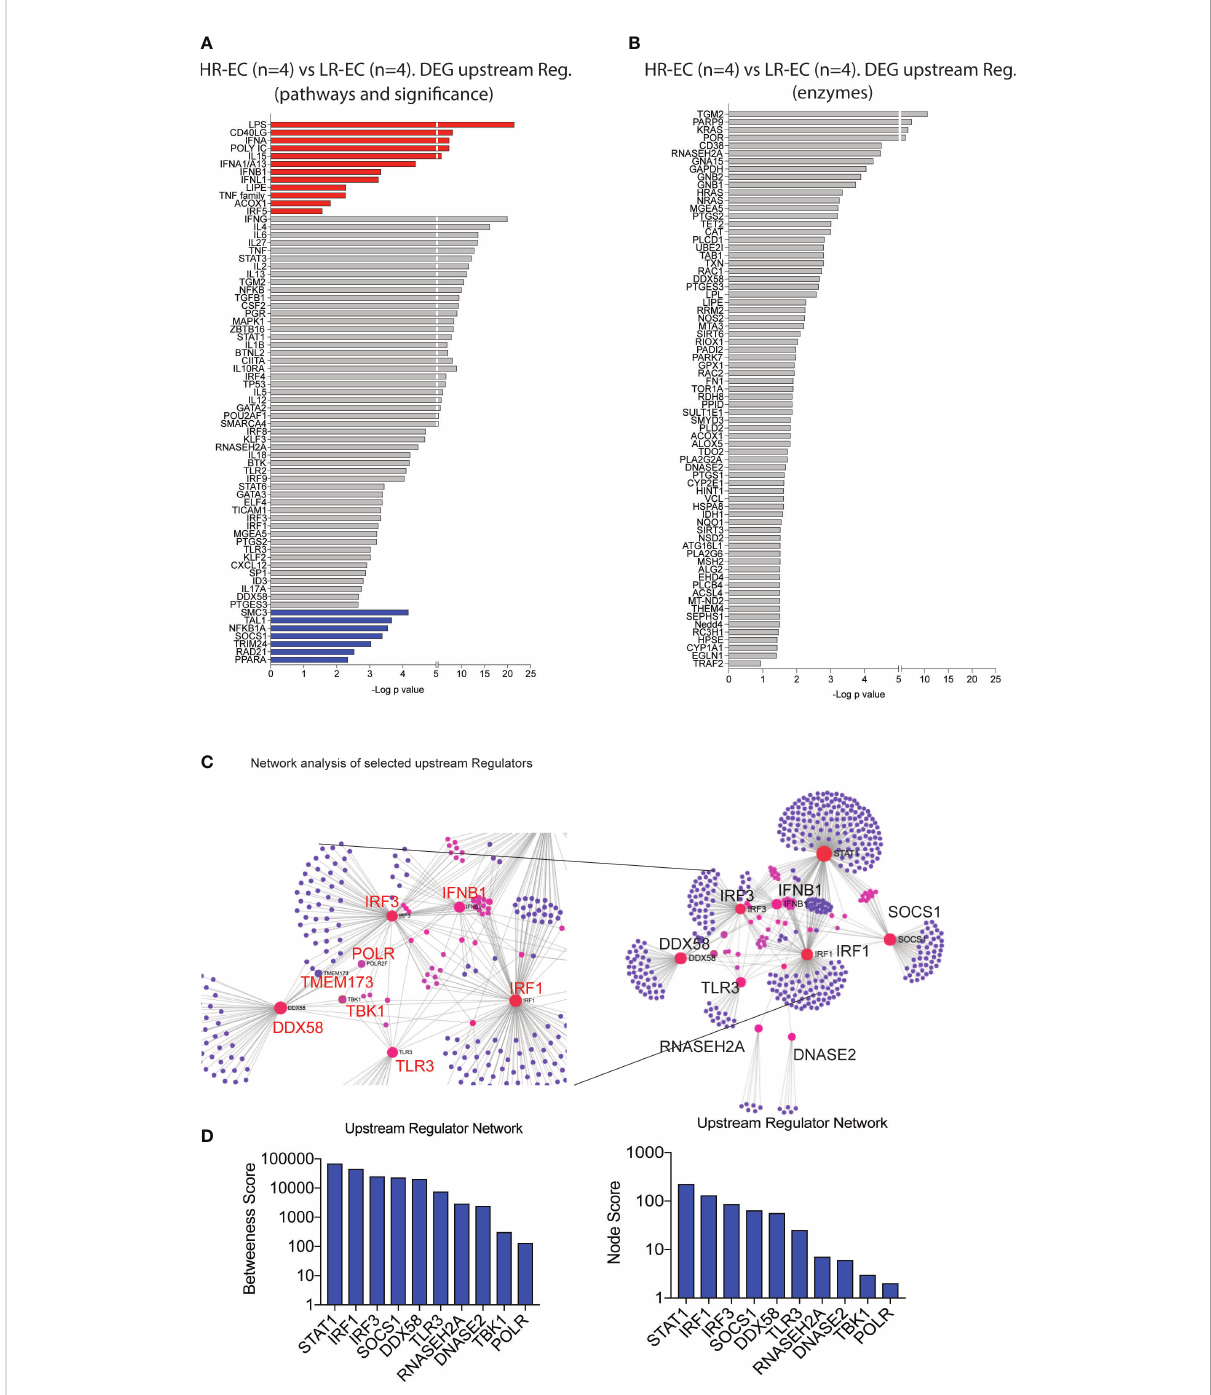
FIGURE 3 Identi fi cation of potential upstream regulators for the high responder EC. (A, B) Selected upstream regulators of DEG distinguishing high responder (HR-EC) vs low responder (LR-EC) EC subgroups, as determined by Ingenuity Pathway Analysis. Data re fl ect all immune pathways (left) or only molecules with enzymatic activity (right). Molecules with a predicted positive upstream effect are highlighted in red, while molecules with a predicted negative effect are in blue. (C) Network interaction of selected upstream regulators identi fi ed in (A) (right panel) highlighting relevant genes within interaction nodes (red) and connecting genes (pink) as well as individual gene targets (violet). Zooms on the central Gene Nodes are displayed in the left panel. (D) Analysis of Betweenness and Node scores of upstream regulator genes included within network de fi ned in (C)